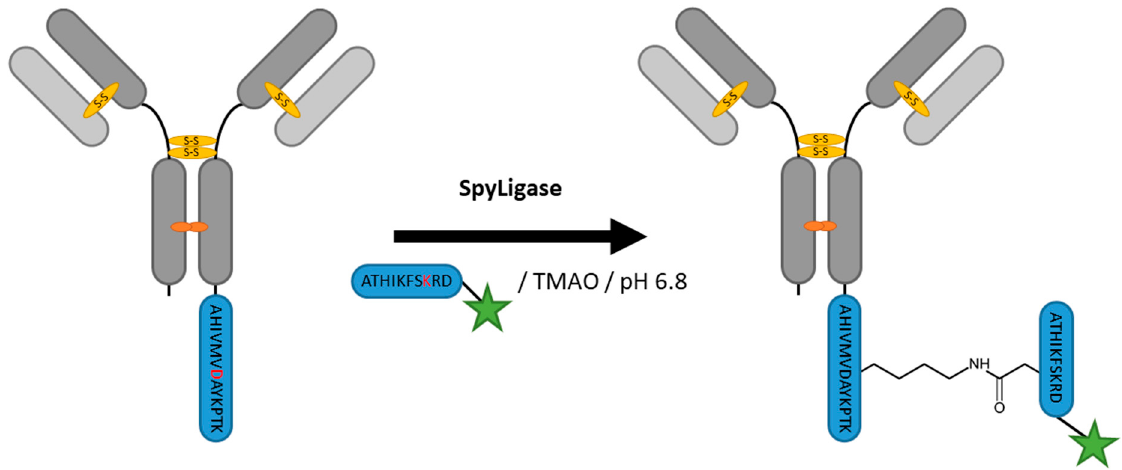
Figure 10. Scheme of an antibody modification by SpyLigase. TMAO, Trimethylamine N-oxide .